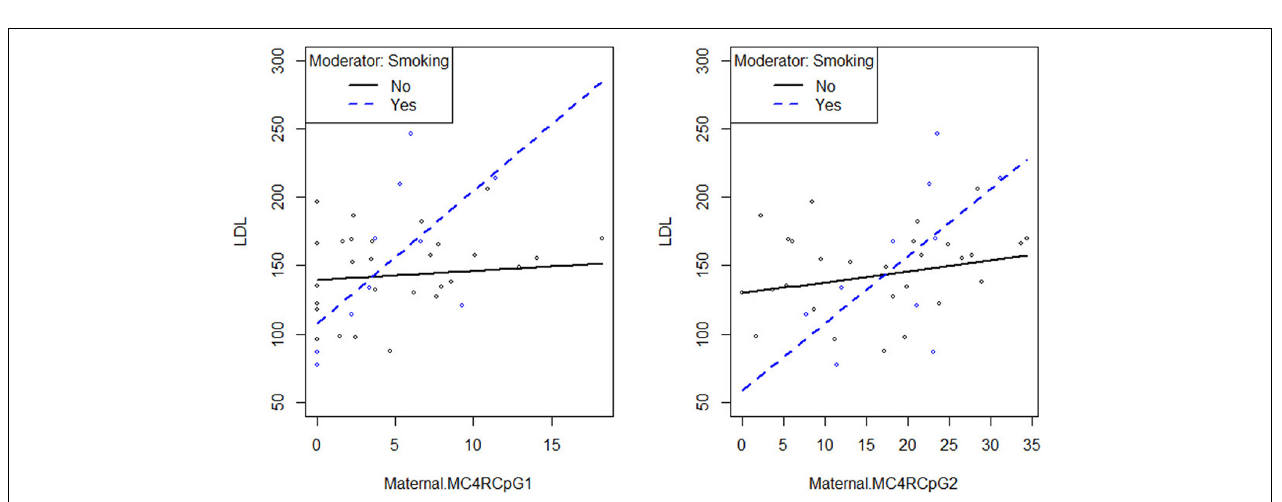
FIGURE 3 | Smoking habit moderates the relation between MC4R DNA methylation at CpG1 on the maternal side and TC at the third trimester of pregnancy ( β smoking = yes ∗ CpG1 DNA methylation = 10.49, p = 0.036).